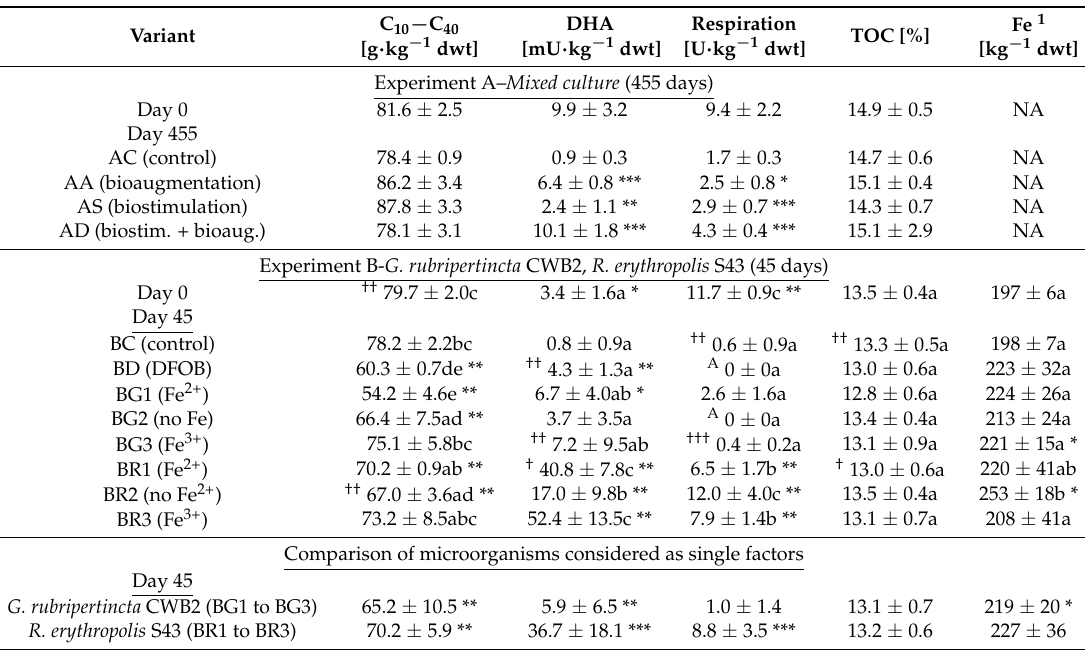
Table 3. Initial and final values for soil parameters (average ± std. deviation from four replications of each variant). Bold face indicates a significant change compared to the initial value, asterisks denote significance compared to control at the end of experiment. Lower-case letters denote homogenous groups according to the Fisher’s Least Significant Difference (LSD) test ( α = 0.05).